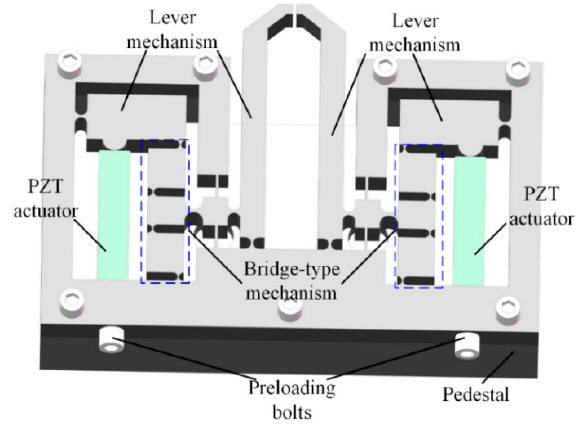
Figure 1. The CAD drawing of the proposed